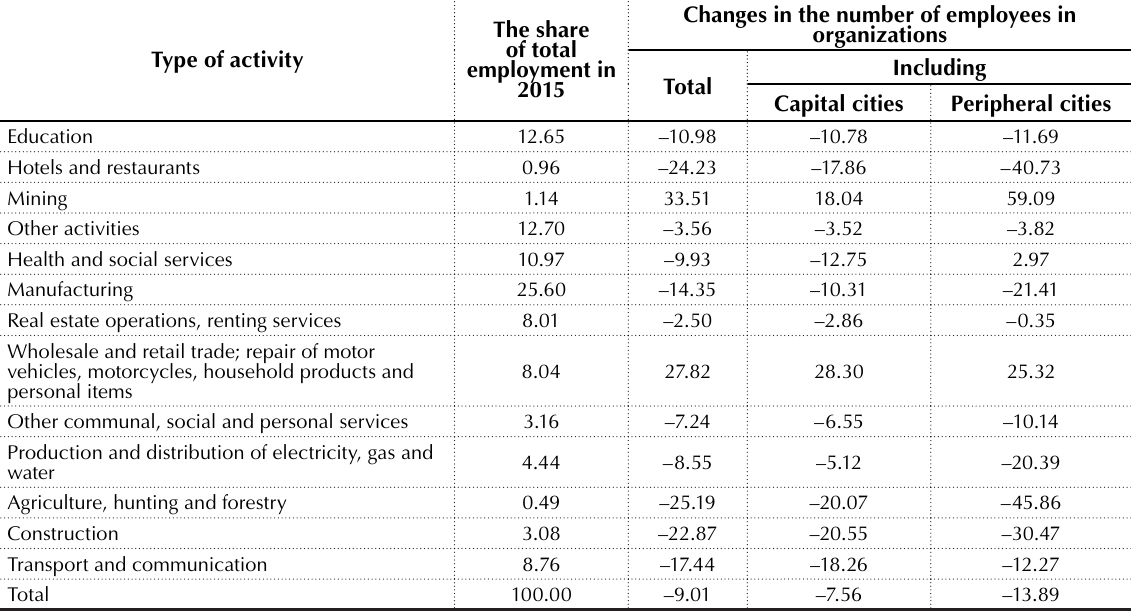
Table 5. Changes in the number of employees in organizations in cities of the Volga Federal District, 2009–2015,